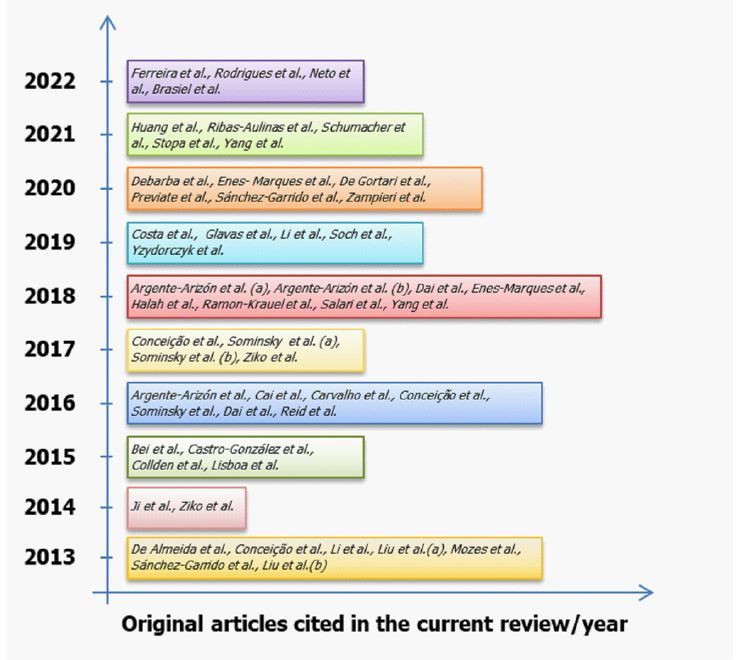
Figure 2. Original articles published per year, since 2013, using the litter size reduction model that was cited in the current review. During the lactation period, the hypothalamic circuits that regulate energy homeo- stasis are still in development and are sensitive to the early hyperinsulinemia and hy- perleptinemia exhibited by the SL model [20]. These hormonal changes could be involved in the altered responses to orexigenic and anorexigenic neuropeptides in paraventricular (PVN) hypothalamic neurons [21], favoring hyperphagia. Then, the metabolic phenotype of SL offspring involves peripheral changes, espe- cially central changes in pathways involved in energy homeostasis control. Many authors have described central resistance to hormones such as leptin [22,23], insulin [24], adi- ponectin [25], ghrelin [26], and cholecystokinin (CCK) [27]. In addition, there are other central modifications that affect the hormonal axis and contribute to metabolic disorders in adulthood. Adaptive changes in the hypothalamus–pituitary–adrenal (HPA) axis have been reported [28], affecting stress responses; in the hypothalamus–pituitary–thyroid (HPT) axis [29], impacting energy expenditure; and in the reproductive axis [30], causing reproductive disorders. Interestingly, several hypothalamic changes occur before weaning, such as leptin resistance at postnatal day (PND) 12 [22], with a downregulation of hypothalamic Ob-Rb at PND 24 [31]. At weaning, the male rat SL offspring show, in the hypothalamic arcuate nucleus (ARC), increased expression of pro-opiomelanocortin (POMC), cocaine and amphetamine regulated transcript (CART), neuropeptide Y (NPY), and ghrelin receptors (GHS-R) [31]. Additionally, this animal model exhibits early alteration of astrocyte morphology at weaning, and it persists until adult life, with increased susceptibility to